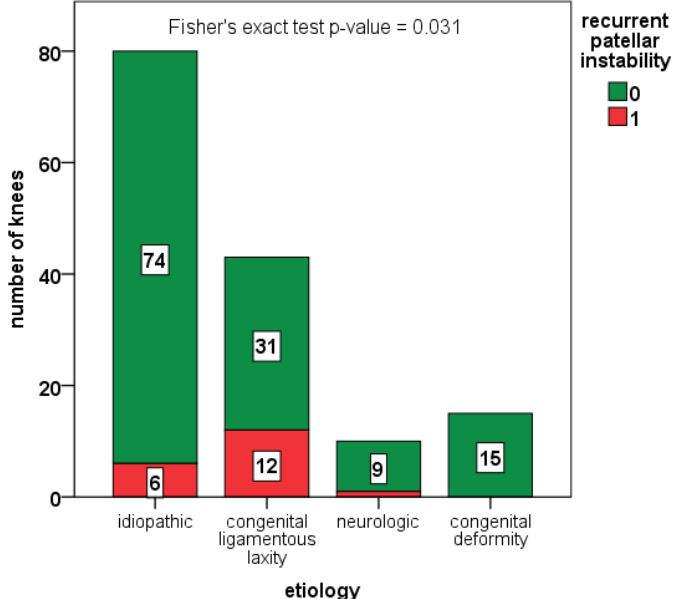
Figure 3. Number of redislocations (depicted in red) among the different subgroups of patients, based on etiology.